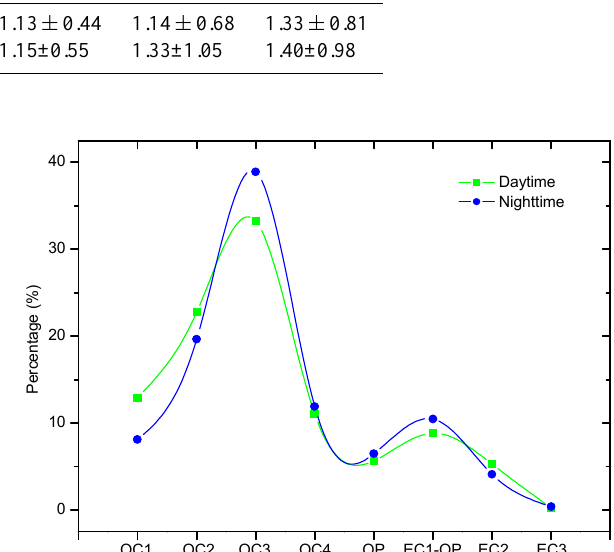
Fig. 2. Average percentage of total carbon contributed by eight car- bon fractions in PM 2 . 5